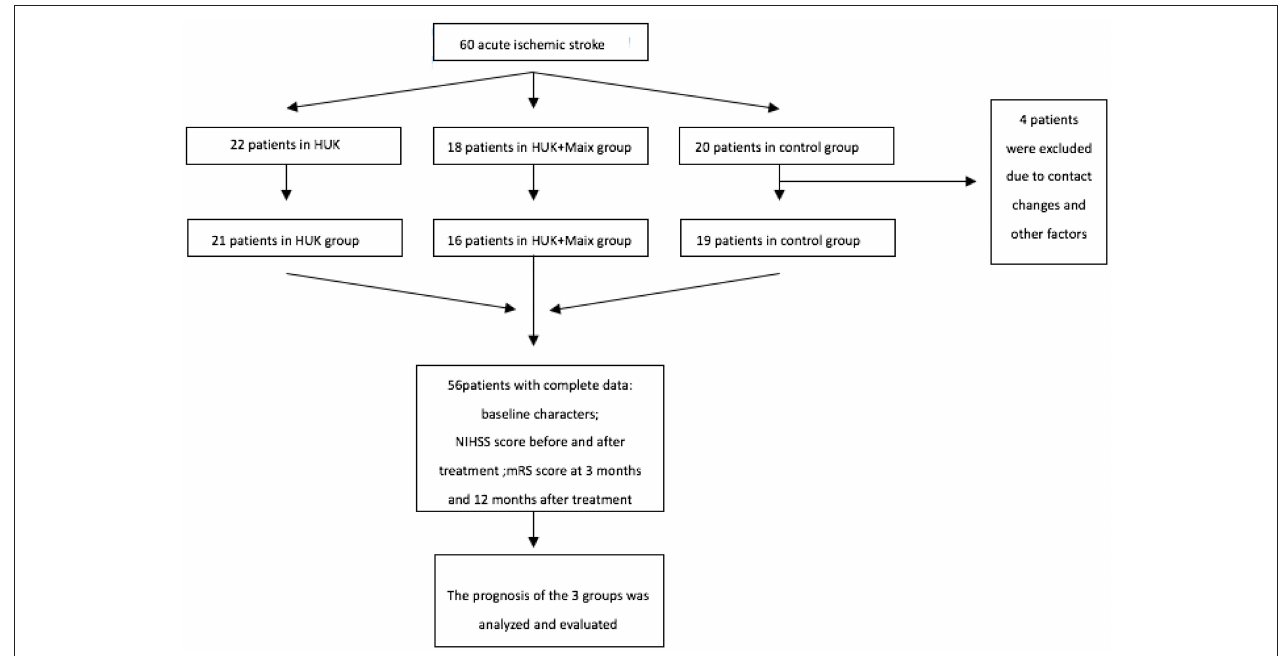
FIGURE 1 | Schematic representation of the study.